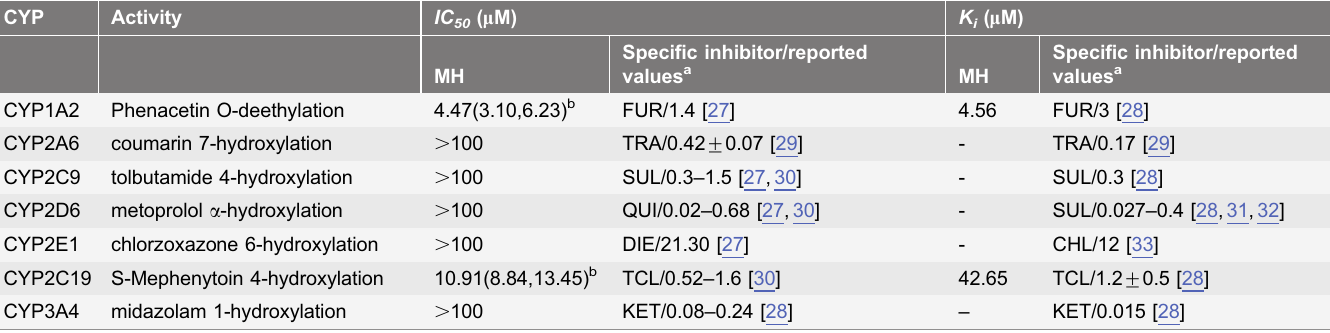
Table 2. IC 50 and K i values of MH against human CYP isoforms compared with that of specific inhibitors reported in literature.